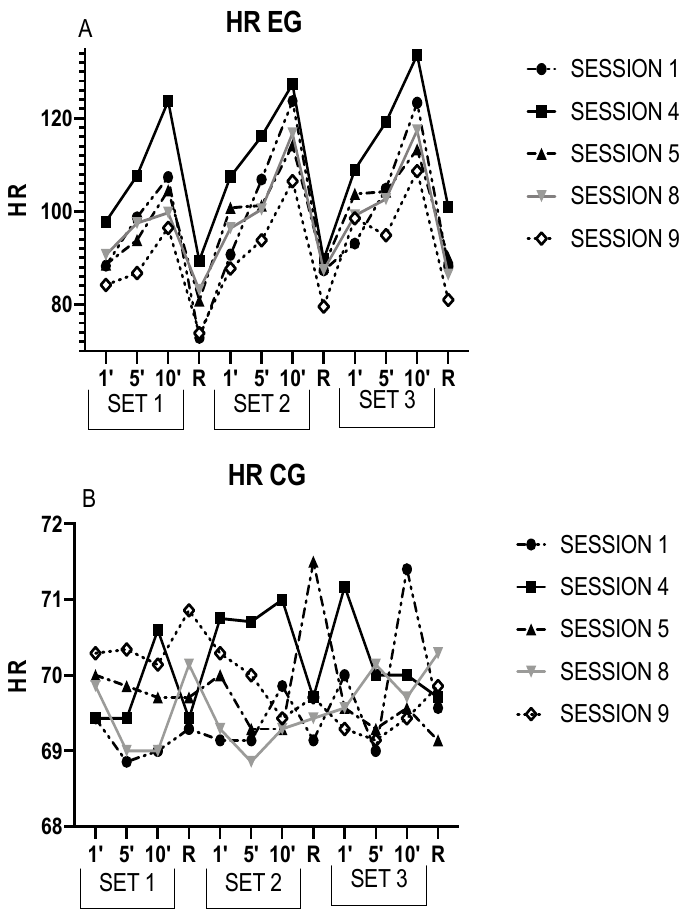
Figure 2. This figure shows the HR during each session in the EG ( A ) and the CG ( B ). R = Recovery. 1 ′ = minute 1; 5 ′ = minute 1; 10 ′ = minute 10.